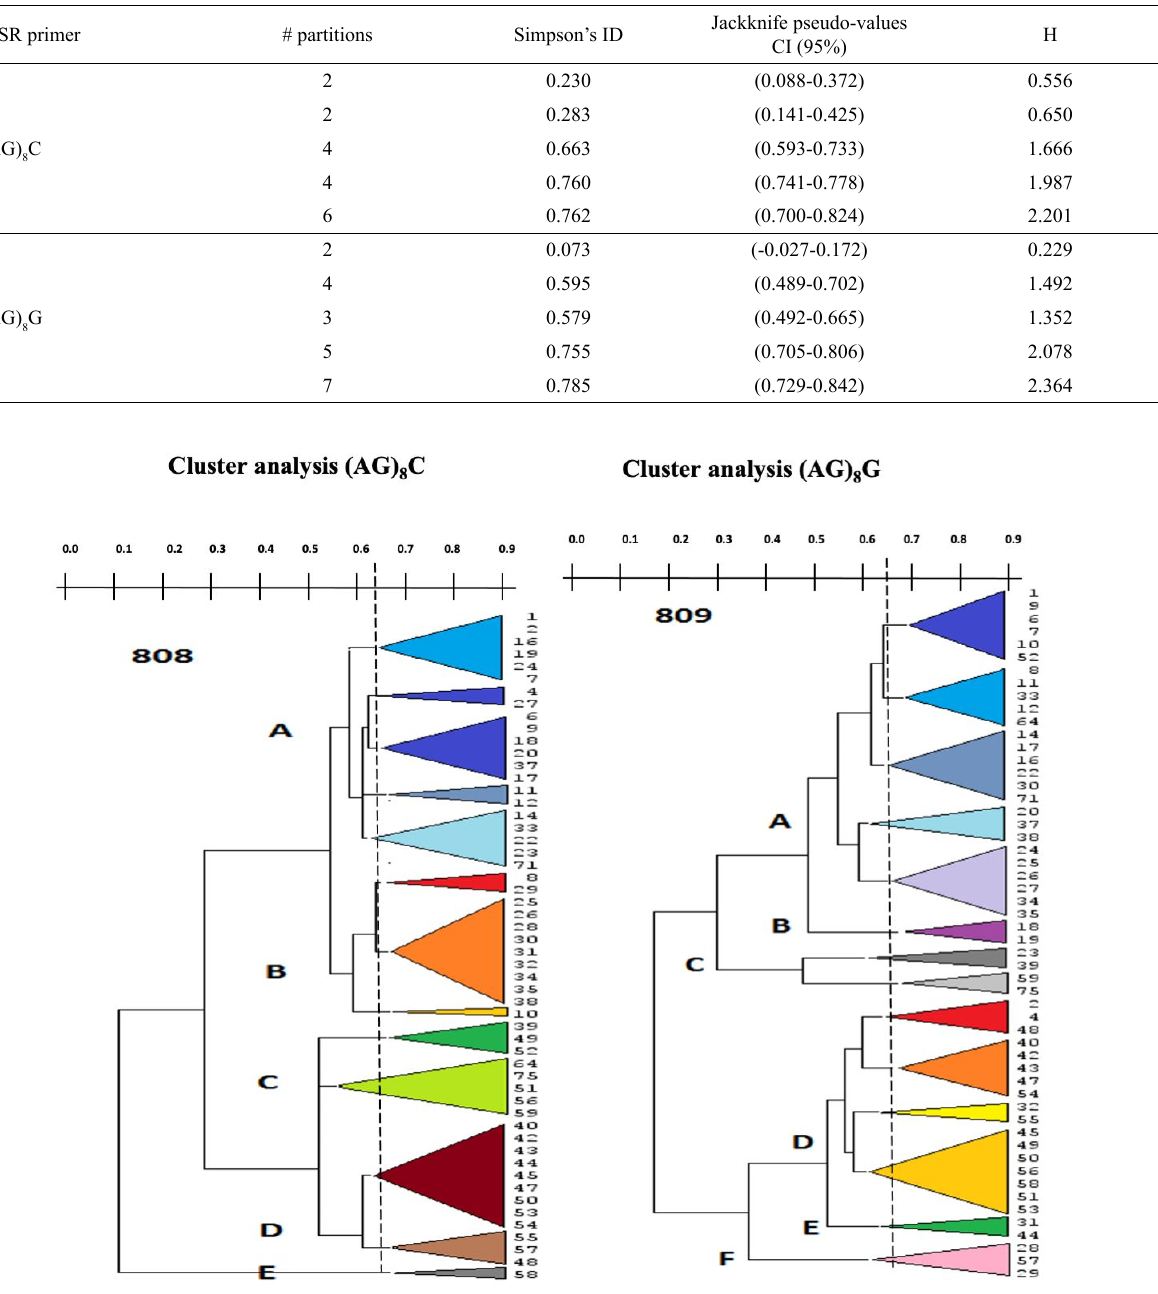
Figure 4 – Diversity and comparative partition using cluster